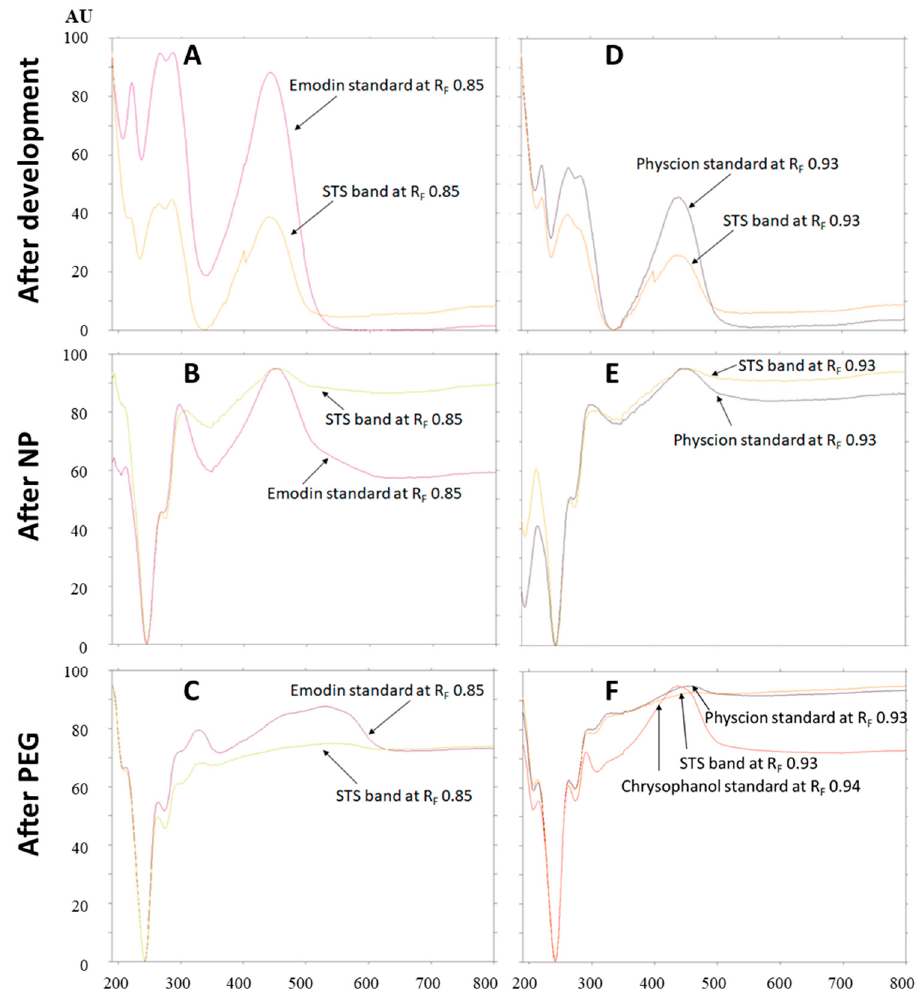
of emodin in the STS. Comparison of the absorption spectra of physcion (R F 0.93) and compounds in the corresponding STS band with the same R F scanned after development (Figure 10D), after post-chromatographic derivatization with NP reagent (Figure 10E) and after the application of PEG reagent (Figure 10F) confirmed that the spectra matched. The possible presence of chrysophanol (R F 0.94), which was not separated from physcion (R F 0.93), was rejected. The rejection was based on the comparison of the absorption spectra of chrysophanol, physcion and compounds in the corresponding STS band with the same R F (Figure 10F). Chrysophanol has a di ff erent shape of absorption spectrum and also di ff erent absorption maxima after development, after post-chromatographic derivatization and after use of PEG reagent (Table 1).